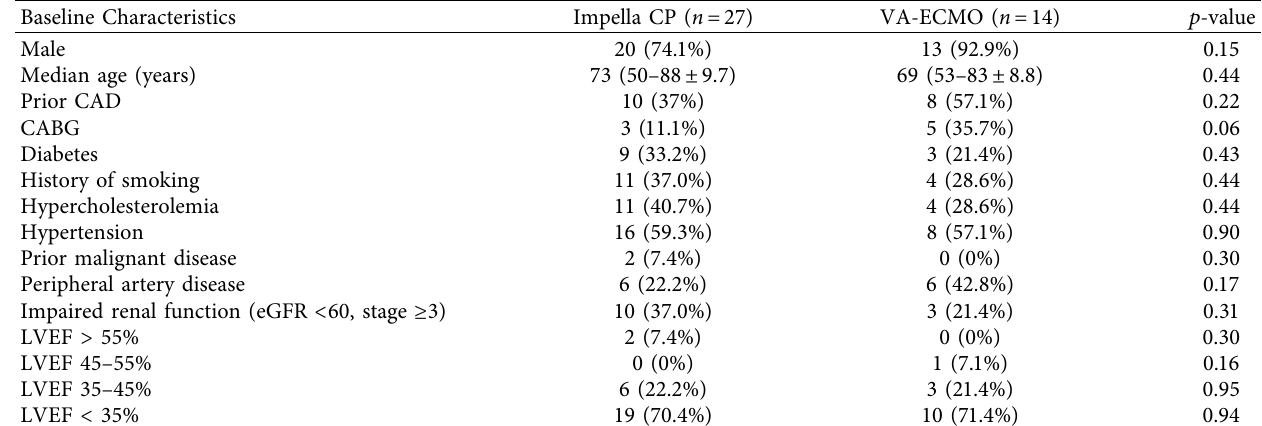
Table 1: Baseline